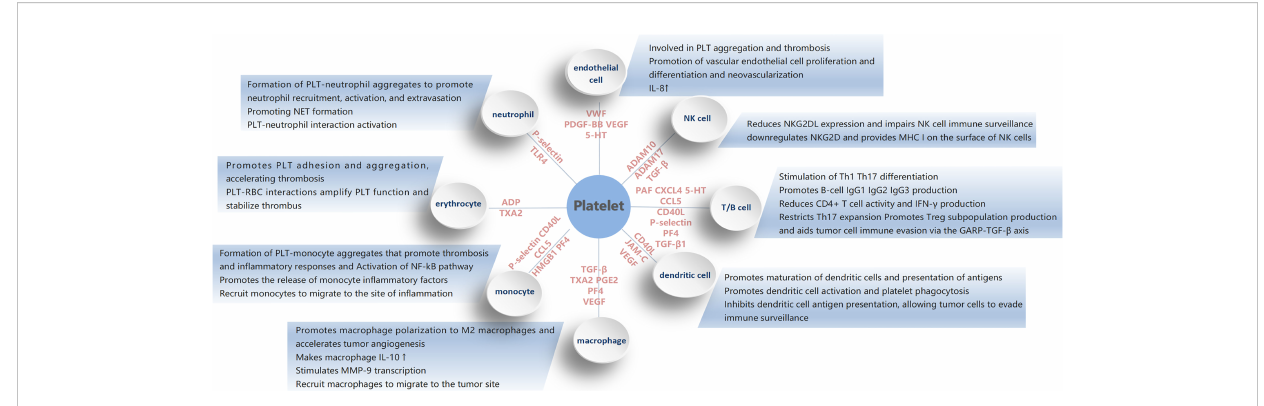
FIGURE 3 The fi gure shows the mechanism of platelet action with various immune